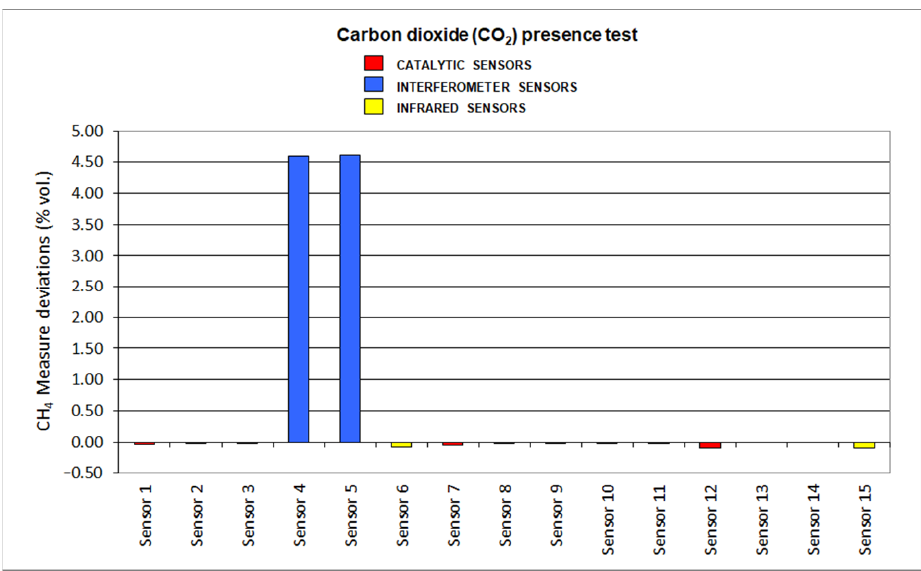
Figure 13. Carbon dioxide presence results.